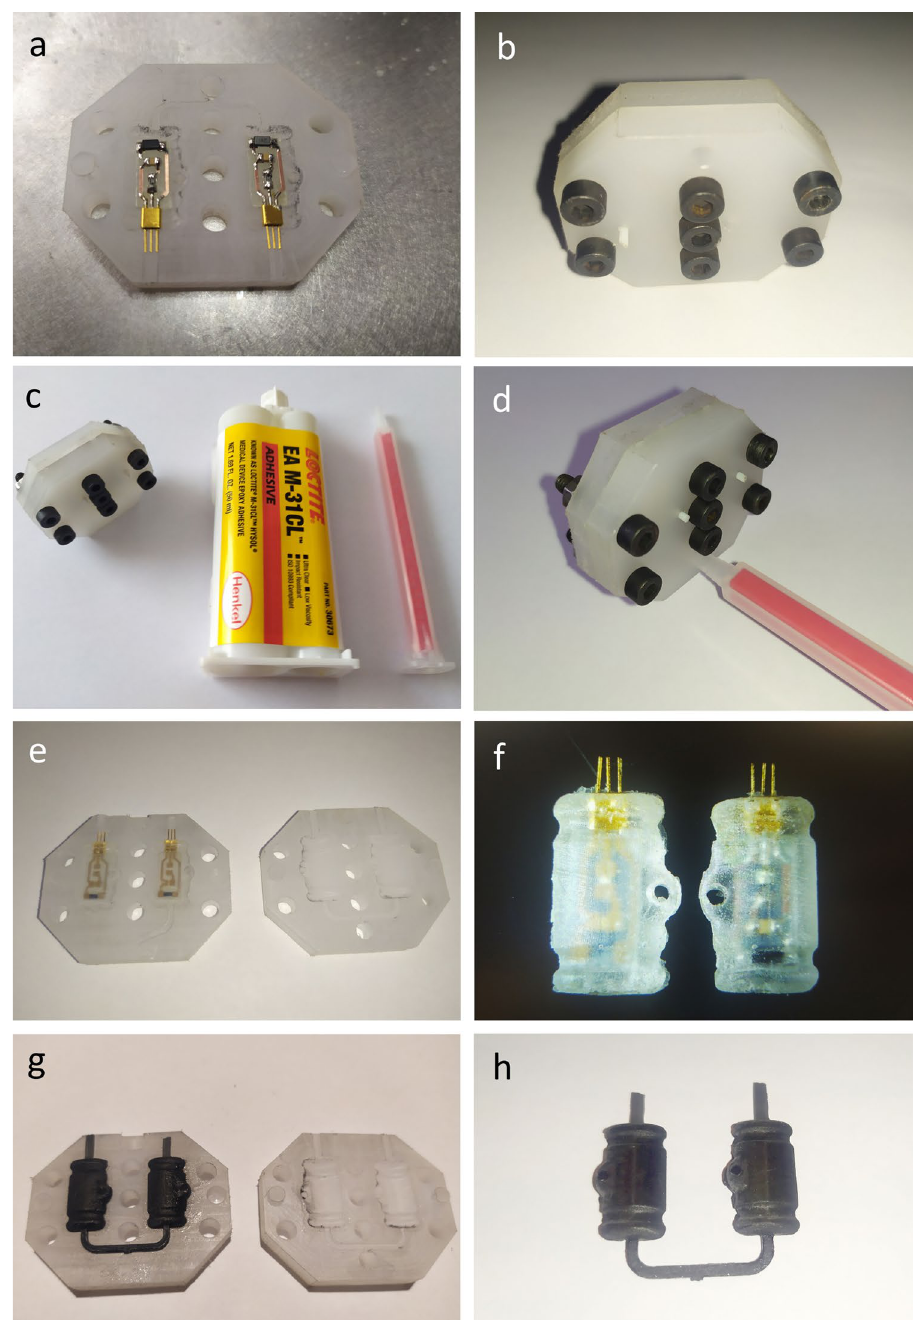
Figure 3. Encapsulation process; ( a ) PCBs inserted to the mold; ( b ) mold closed with side pins present; ( c ) epoxy cartridge with the mold; ( d ) insertion of the static mixer to the gate; ( e ) after mold halves separation; ( f ) detailed view of encapsulated devices; ( g ) test run with black PDMS to provide better visibility; ( h ) PDMS parts with visible sprues and part of the